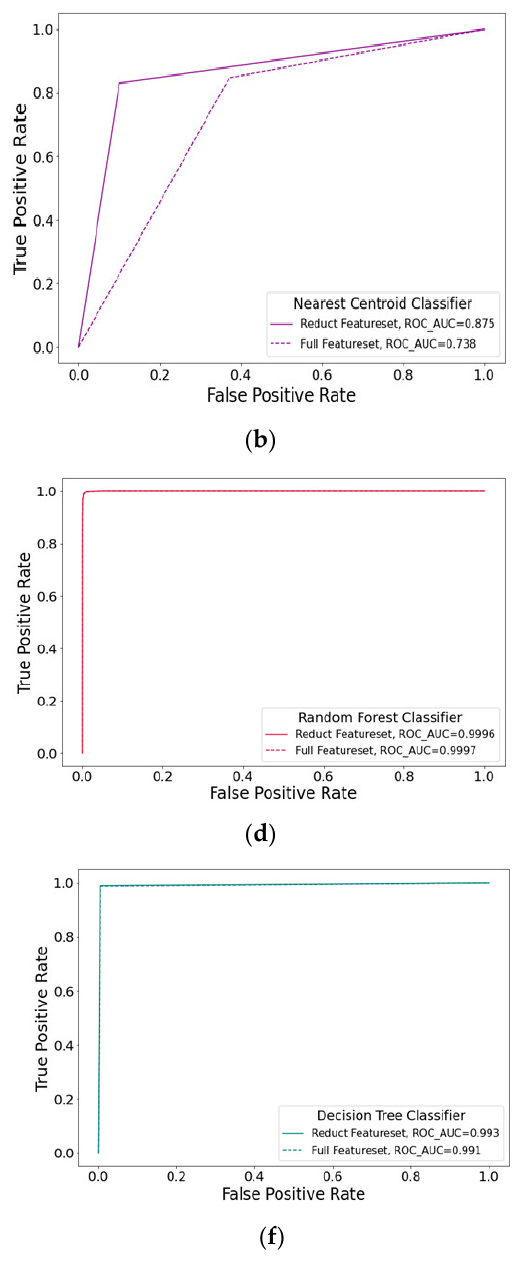
Figure 3. ( a ) ROC curves for ACO-KNN; ( b ) ROC curves for ACO-NC; ( c ) ROC curves for ACO-GNB; ( d ) ROC curves for ACO-RF; ( e ) ROC curves for ACO-SVM; ( f ) ROC curves for ACO-DT. Table 13. Details of the features selected from Run 1 of Table